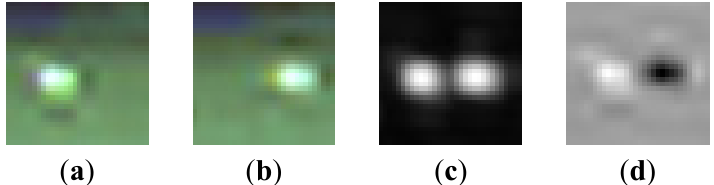
Figure 13. ERGAS-SNS analysis of a bright vehicle: ( a ) composite MS1 image; ( b ) composite MS2 image; ( c ) ERGAS result; ( d ) SNS result.